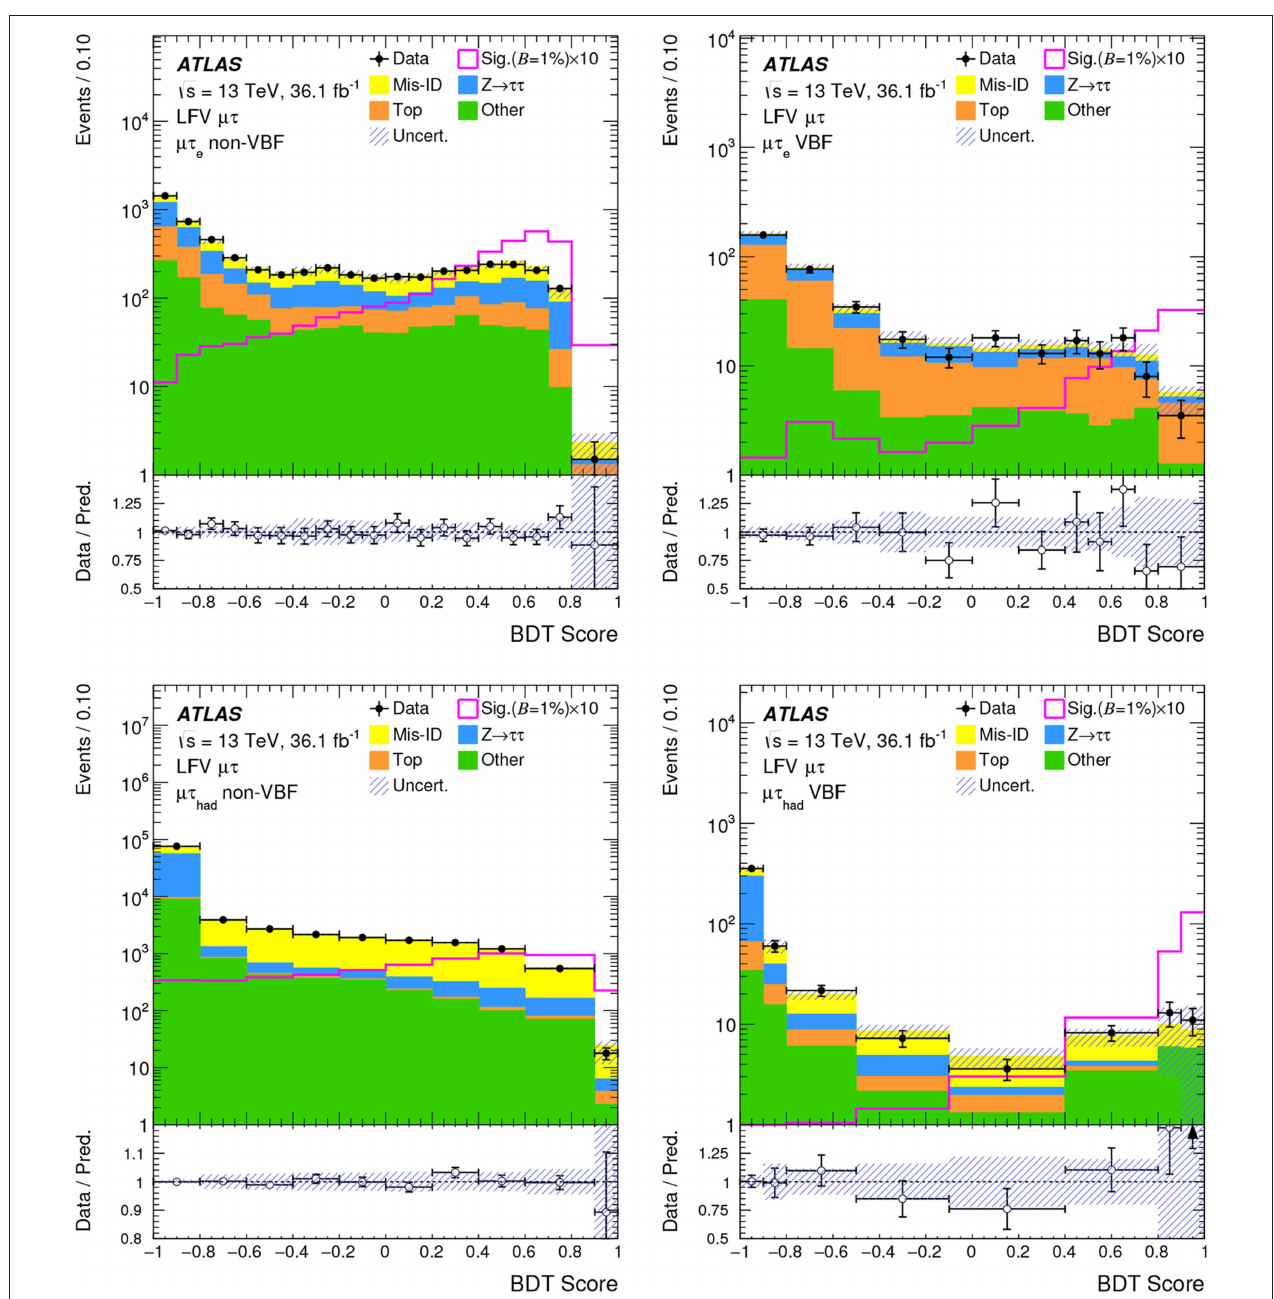
FIGURE 3 | Distributions of the BDT score after the background+signal fit in each signal region of the µτ search, with the LFV signal overlaid, normalized with B ( H µτ ) 1 % and enhanced by a factor 10 for visibility. The top and bottom plots display µτ e and µτ had BDT scores, respectively, the left (right) column → = corresponds to the non-VBF (VBF) category. The size of the combined statistical, experimental and theoretical uncertainties of the background is indicated by the hatched bands. The binning is shown as in the statistical analysis. In the data/background prediction ratio plots, points outside the displayed y -axis range are shown by arrows. Reproduced from ATLAS Collaboration [49] under the Creative Commons CC-BY-4 license.